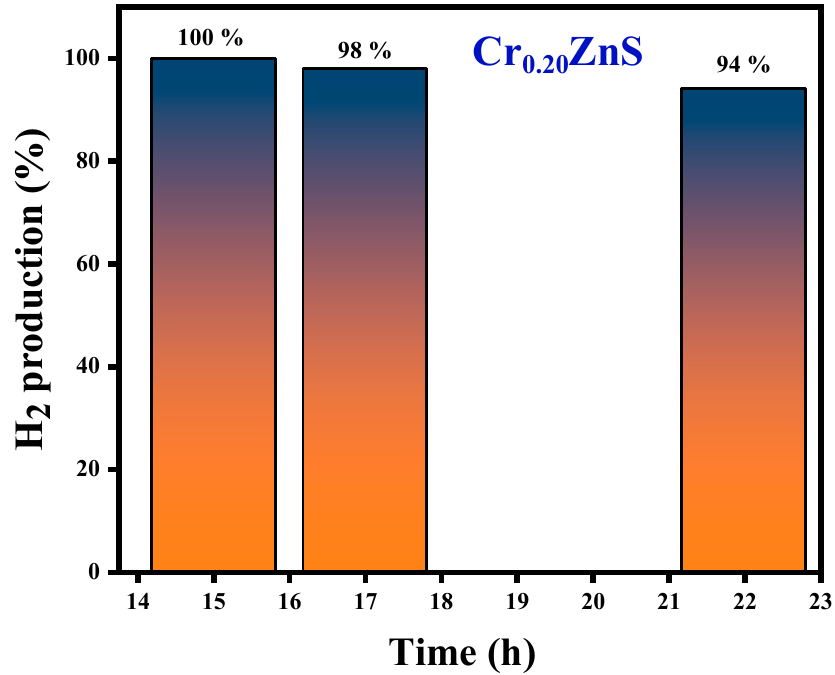
Figure 11. H 2 production of the Cr 0.20 ZnS catalyst with time.